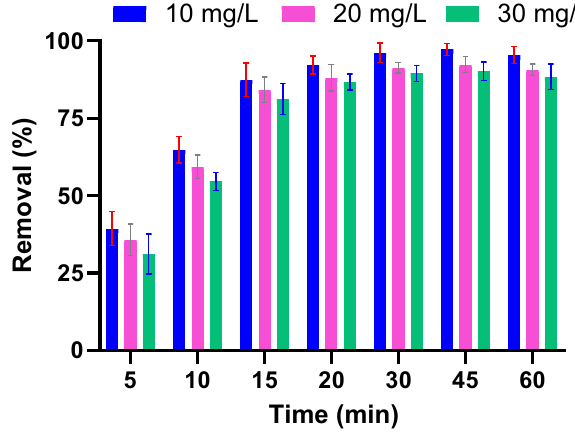
Figure 4. Pb(II) removal as a function of Pb(II) concentrations. (PG: 10 g/L).